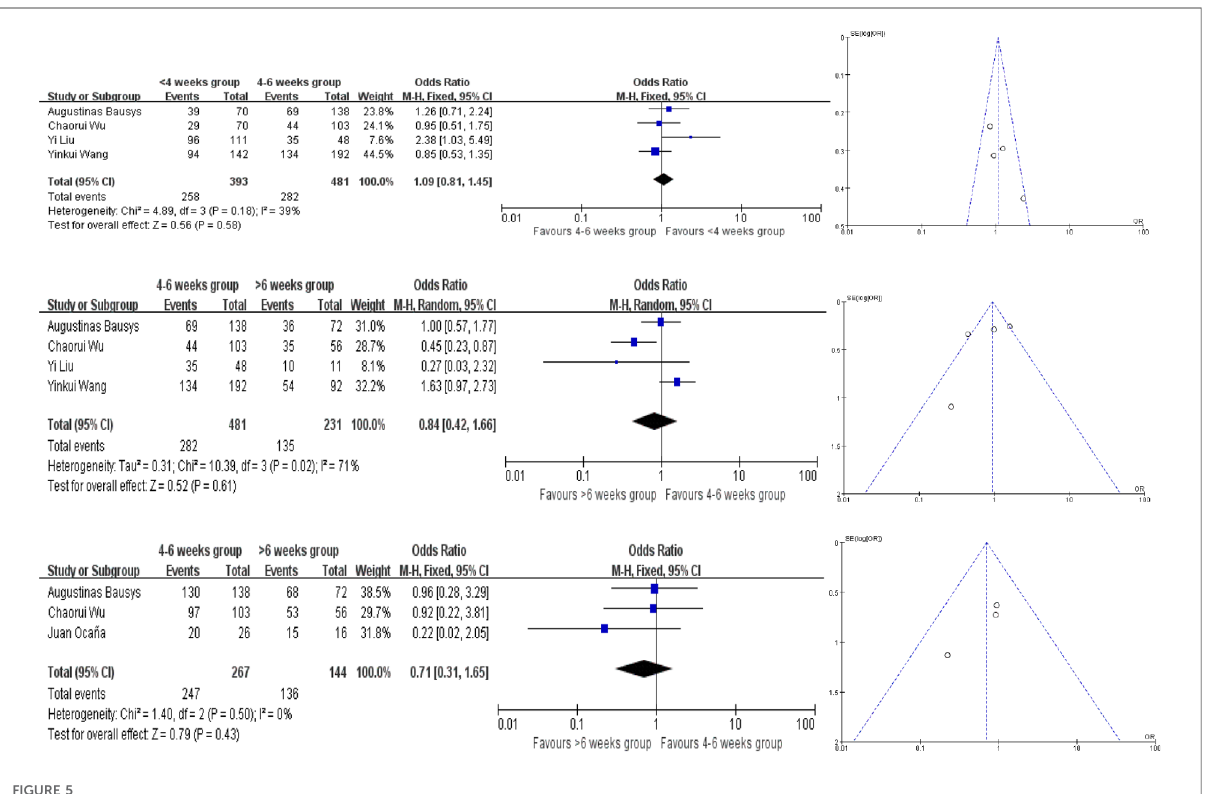
FIGURE 5 Forest plot and funnel plot for 3-year PFS rates meta